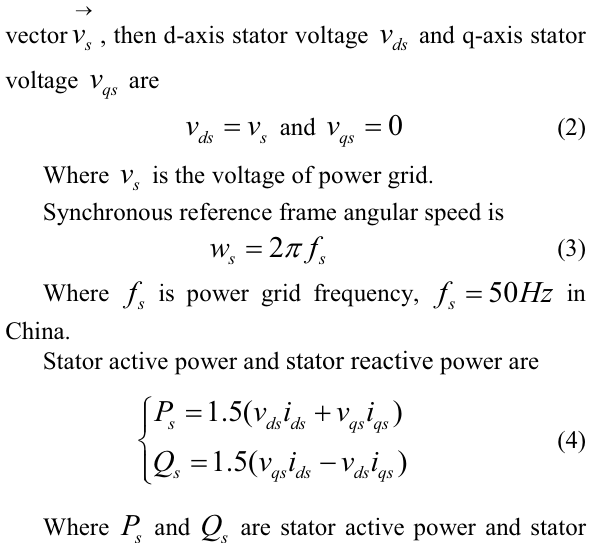
Fig.2. Wind farm reactive power diagrammatic drawing